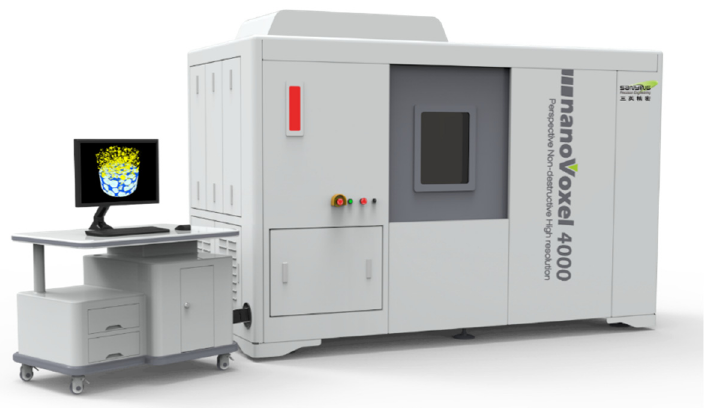
Figure 3. High resolution X-ray micro CT.